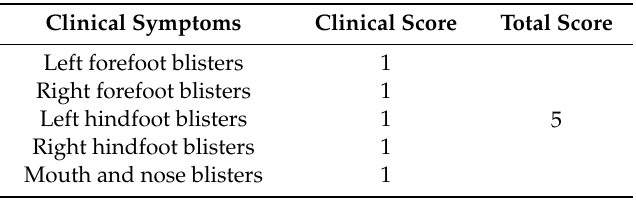
Table 3. Clinical symptom scores for SVA-infected